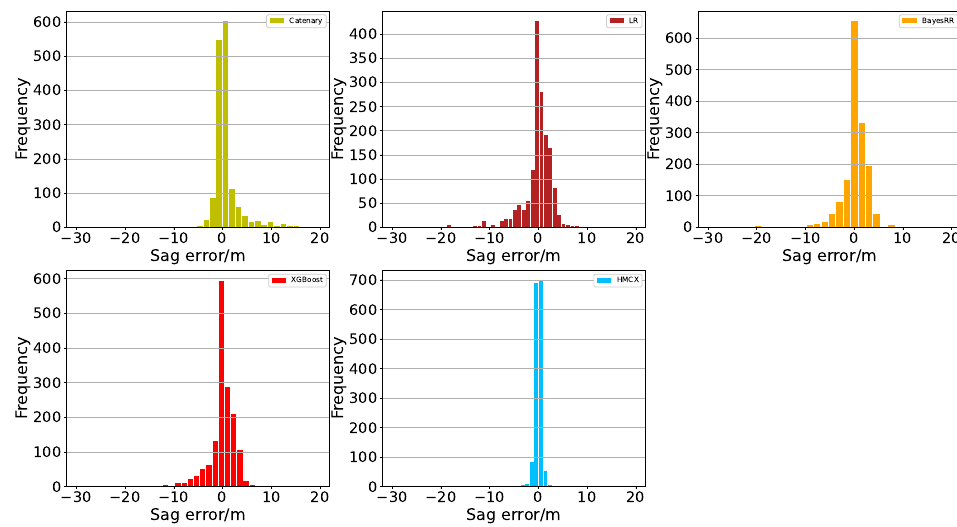
Figure 10. Sag estimation errors of all data.